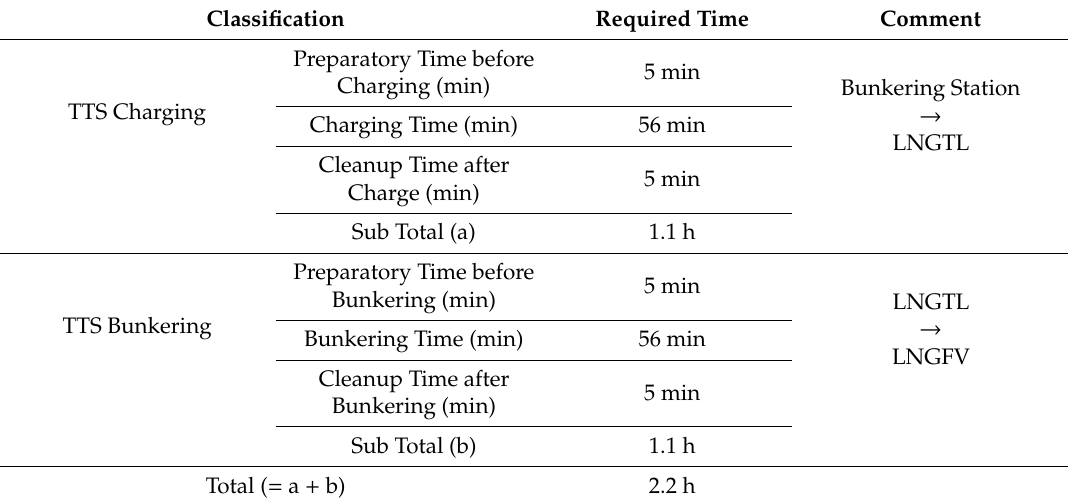
Table 11. LNG Charging Time and Bunking Time by TTS Method in Pusan